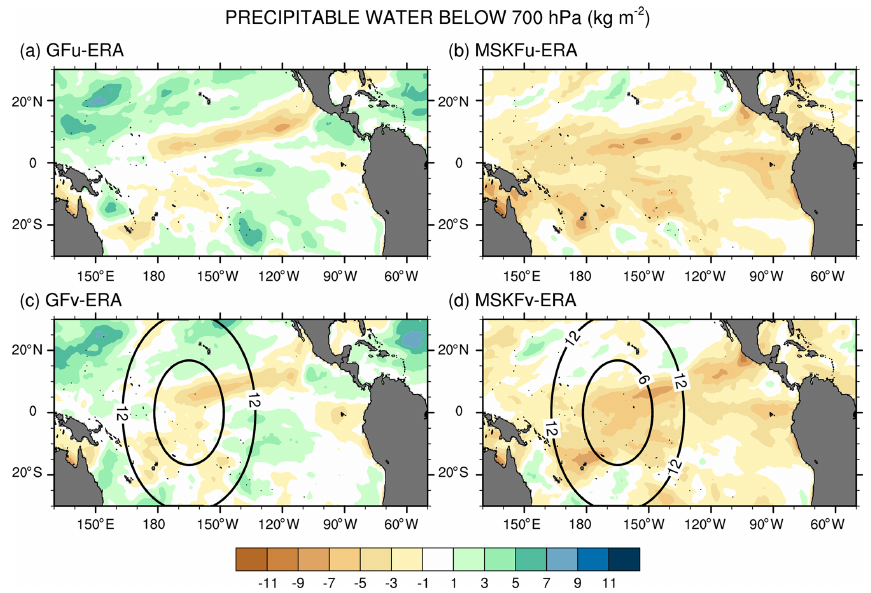
Figure 14. Monthly-mean difference between the simulated and ERA-Interim precipitable water below 700hPa over the tropical Pacific Ocean for December